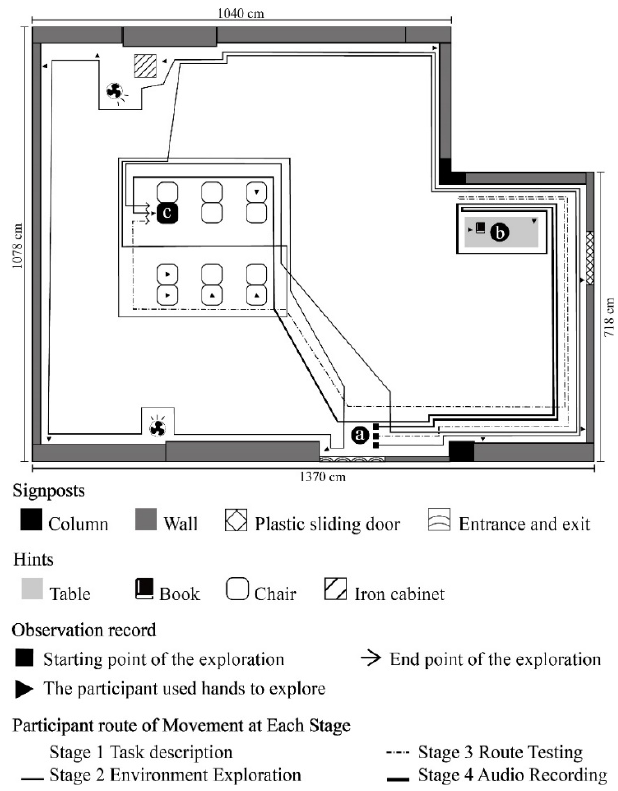
Figure 5. A3 participant’s route of movement at each stage.